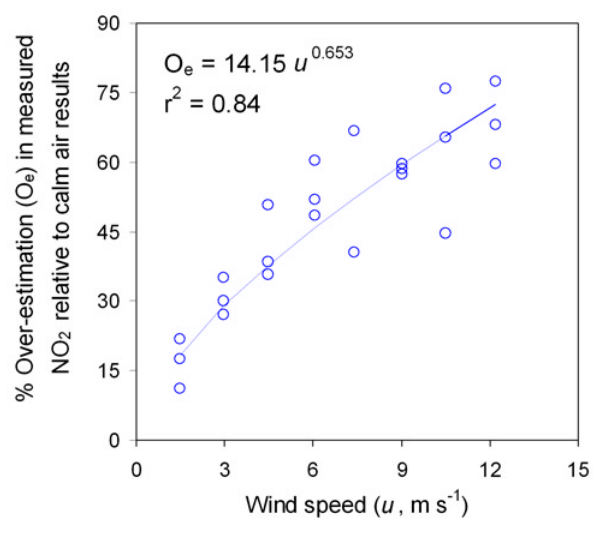
FIGURE 2. Effect of wind speed on the over-estimation of NO 2 concentration for 71 mm diffusion tubes (adapted from Hargreaves